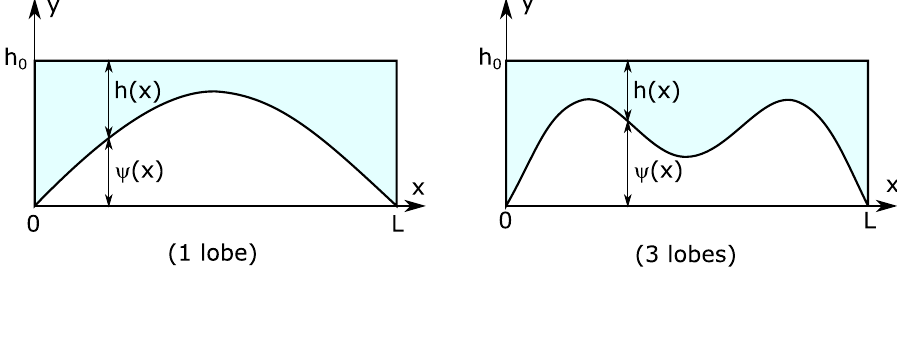
emptying function ( N = 1 lobe) and the two sine emptying function ( N = 3 lobes), as also depicted in Fig. 1.